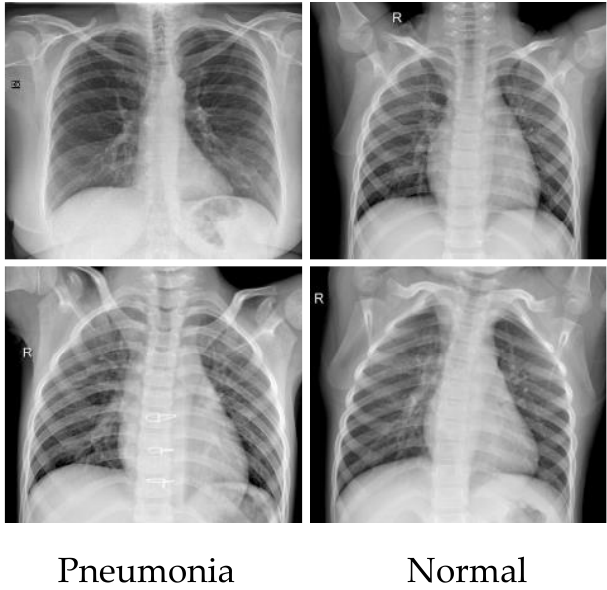
Figure 3. The partial CXR images of the Coronahack dataset. Table 2. Detailed information about the COVID-19 Radiography database.